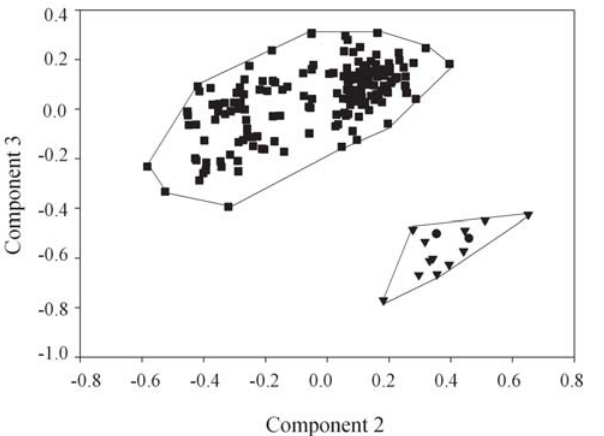
Fig. 2 . Principal components analysis on covariance matrix of log-transformed measurements of Pimelodus microstoma from the upper Paraná (inverted triangles), syntypes of Pimelodus microstoma (dots), Pimelodus maculatus (diamonds), Pimelodus fur (squares), and Pimelodus sp.